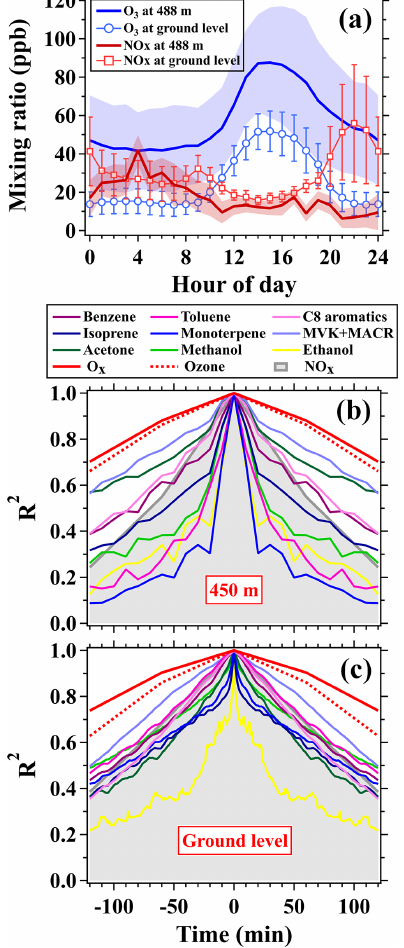
Figure 4. (a) Diurnal profiles of ozone and NO x mixing ratios mea- sured at the 488m site (mean ± SD – standard deviation) and the surface site (mean ± 0.5SD) on the CTT. (b) Autocorrelation of the time series of ozone (488m), NO x (488m), O x (488m), and se- lected VOC species (450m) during the CTT campaign. (c) Auto- correlation of the time series of the selected VOC species at ground level during the GIG campaign. Autocorrelation of the time series of ozone, NO x , and O x in panel (c) is calculated using the mea- surements made at the surface site of Canton Tower during the CTT